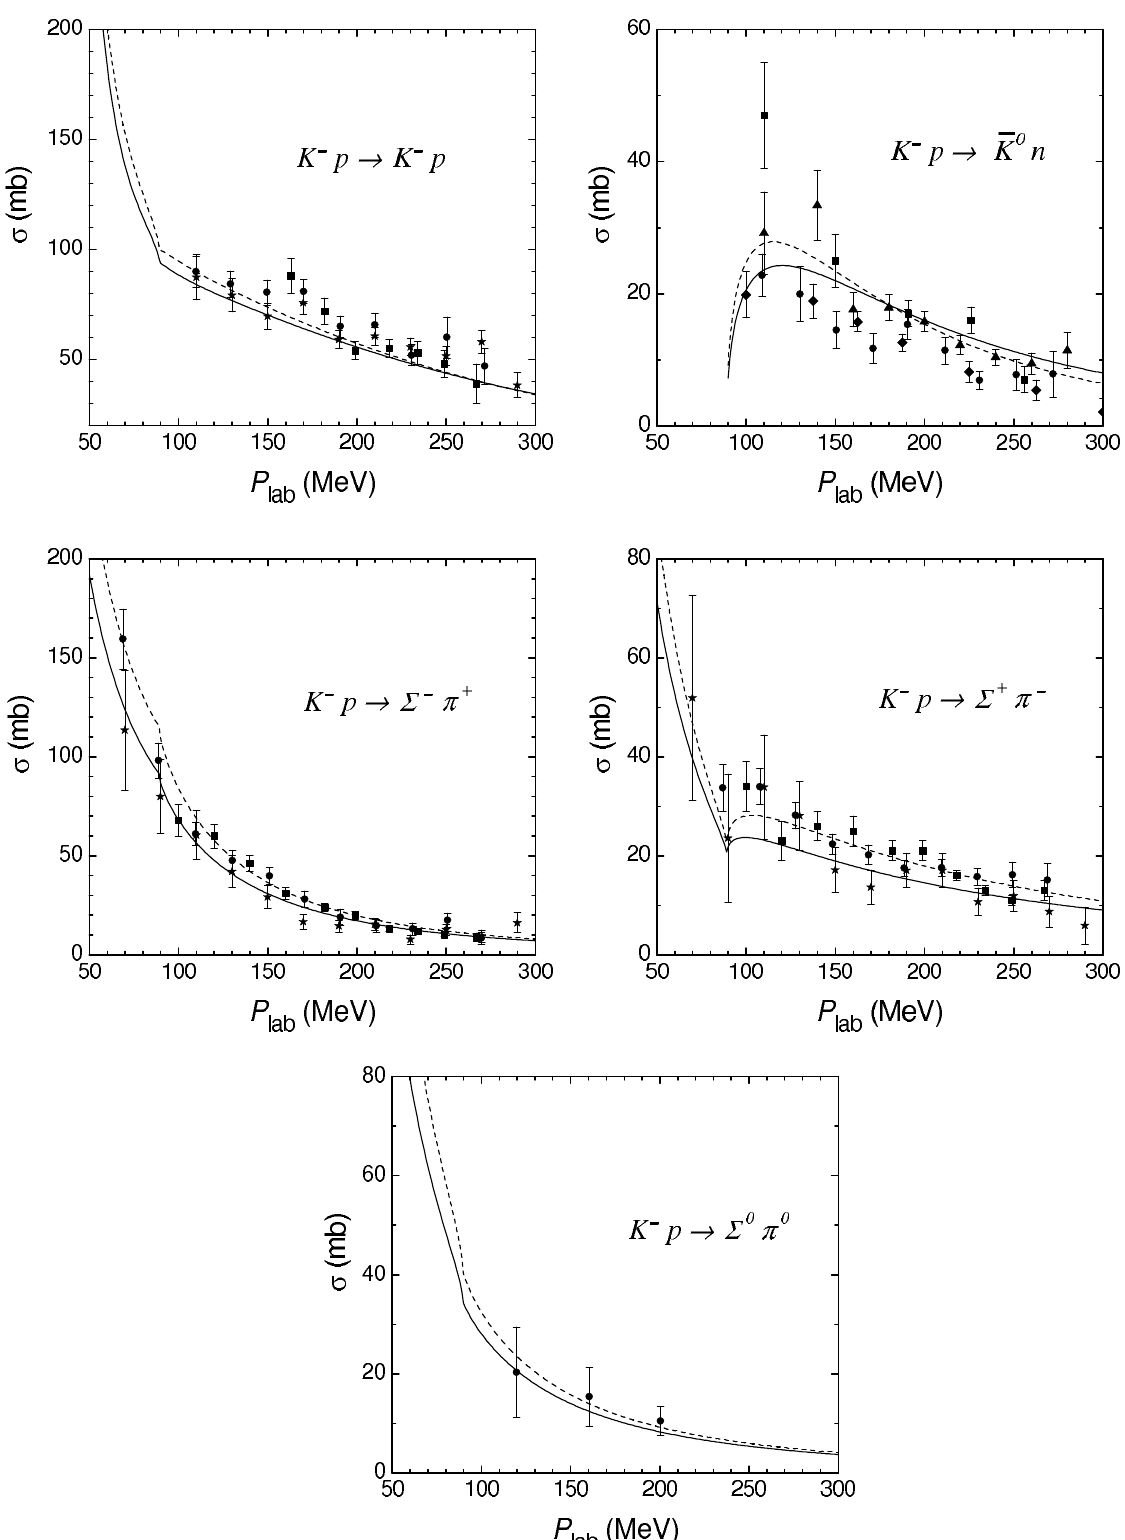
Fig. 2. Comparison of the obtained theoretical cross-sections (lines) with experimental data [13–17] (points). Solid lines: calculation with one-pole Λ (1405) resonance, dashed lines: calculation with two-pole Λ (1405) resonance.